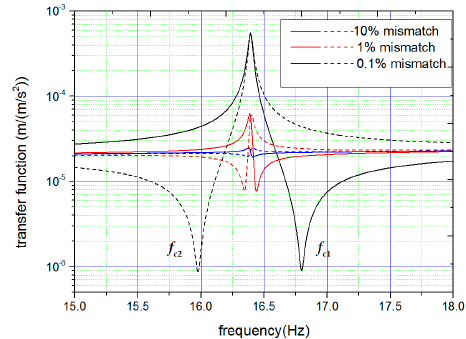
Figure 2. Calculated frequency response functions of displacement for each test mass at different mismatch of stiffness. The solid and dashed lines are used to distinguish the different test masses. When the mismatch of stiffness becomes smaller, both the difference between f c 1 and f c 2 and the depth of the valley keep